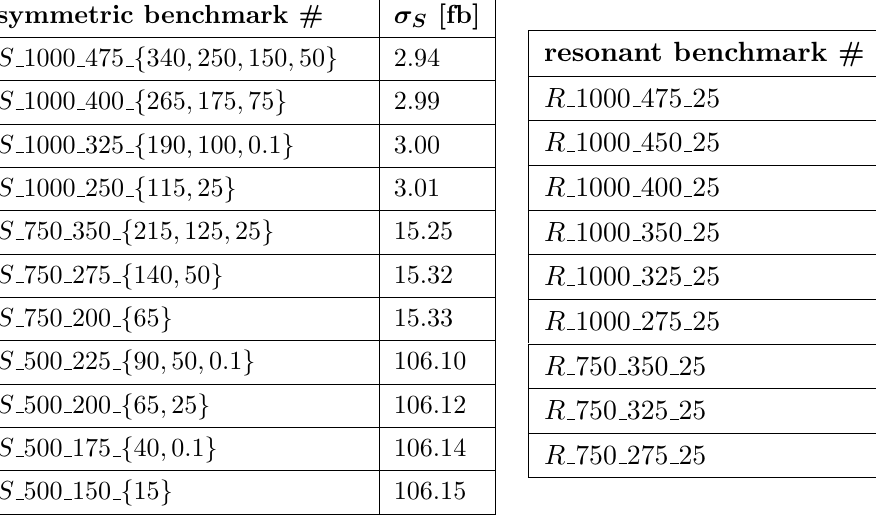
Table 1 . Benchmarks S m B m A m (cid:31) (symmetric topology, left) and R m B m A m (cid:31) (resonant topology, right) for a di-Higgs plus =E signature. The second column shows the signal rate T (cid:27) S;R ( pp ! b (cid:22) b b (cid:22) b (cid:31)(cid:31) ) at a centre-of-mass energy of 14 TeV, assuming a UV completion by a vector-like quark with m Q = 1 TeV and y Q = 1, see appendix